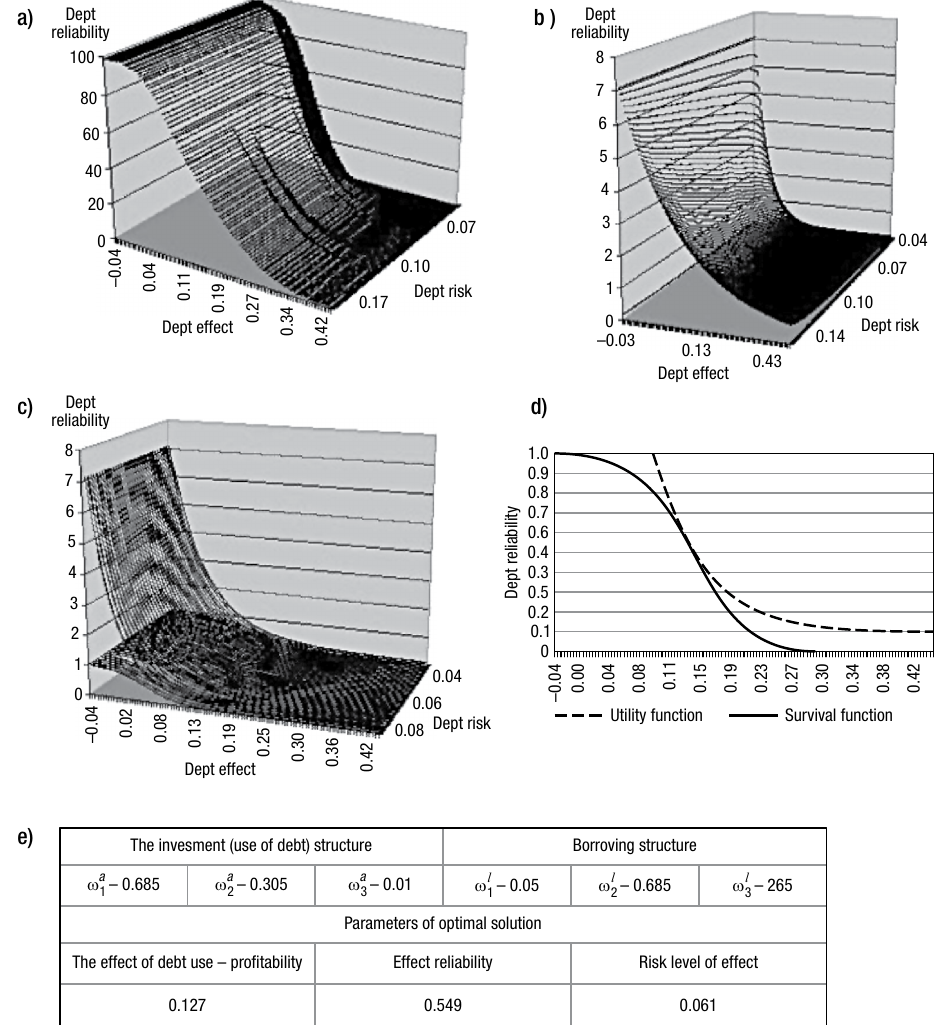
Fig. 5. The anatomy of decision search: a) three-dimensional surface; b) utility function; c) possibility surface and utility function – three-dimensional view; d) possibility surface and utility function – the tangency point; e) the information about optimal